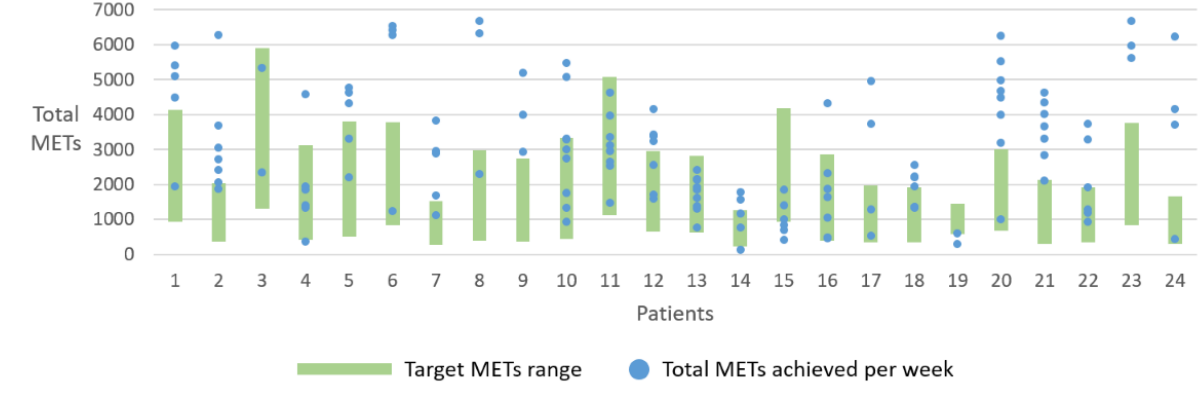
Figure 10. Chart showing weekly physical activity targets and totals METs achieved each week by patients that used the physical activity module of the HeartHab app. The chart depicts only complete data for weeks when a patient registered activities. MET: Metabolic Equivalents of Task.